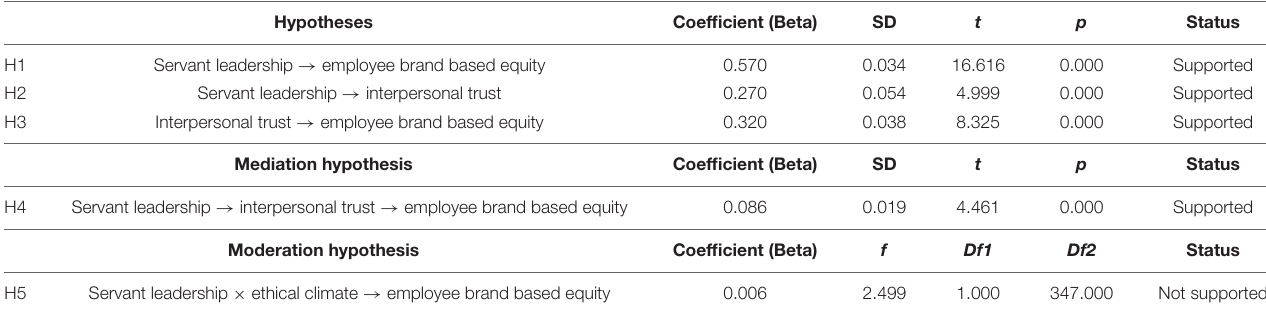
FIGURE 3 | Path significance. TABLE 5 | Hypotheses